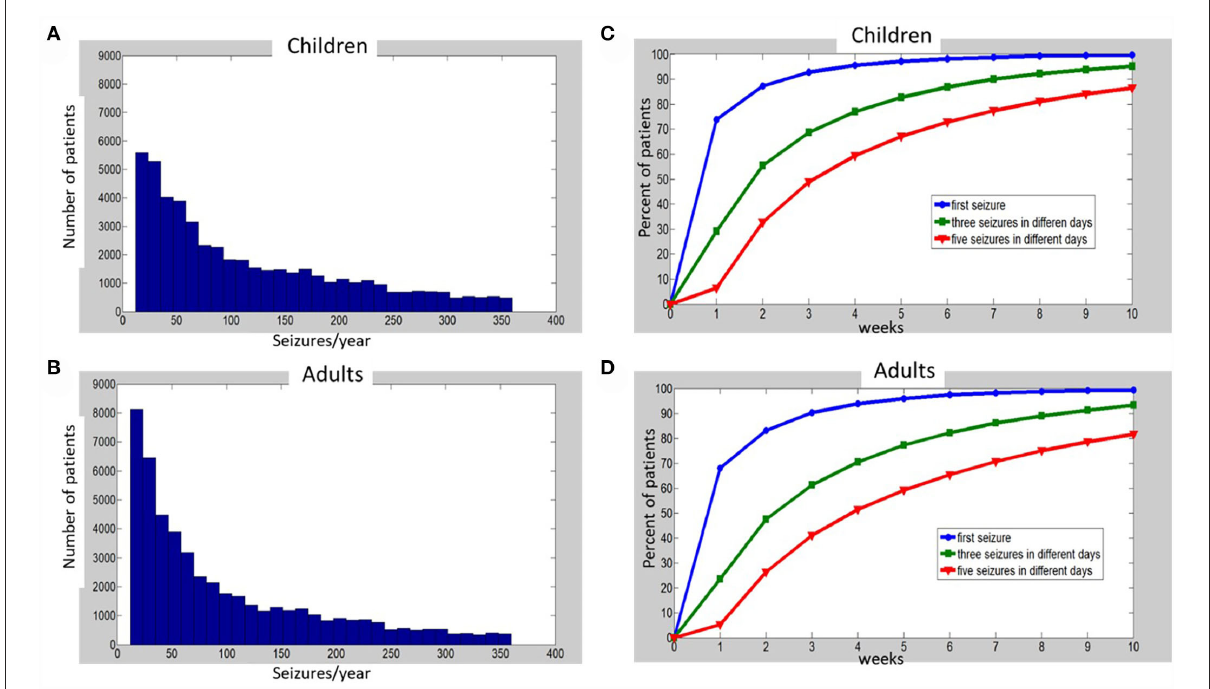
FIGURE1 Histograms of simulated annual seizure frequencies distribution among 50,000 children (A) and 50,000 adults (B) with epilepsy, and percentages of patients (C—children, D—adults), for which one (blue), three (green), or five (red) seizures on different days were captured at the end of each week, up to 10 weeks of monitoring. See Supplementary material for details of simulations and Supplementary Tables S1, S2 for the raw data that were used to build the charts (C,D)